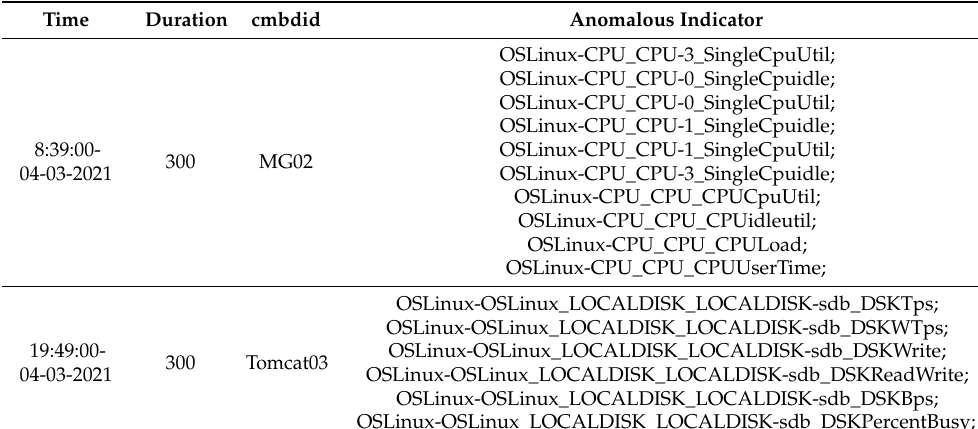
Table 3. Part of the fault tag file. The table contains two abnormal periods, each of which contains multiple abnormal indicators suspected as root cause